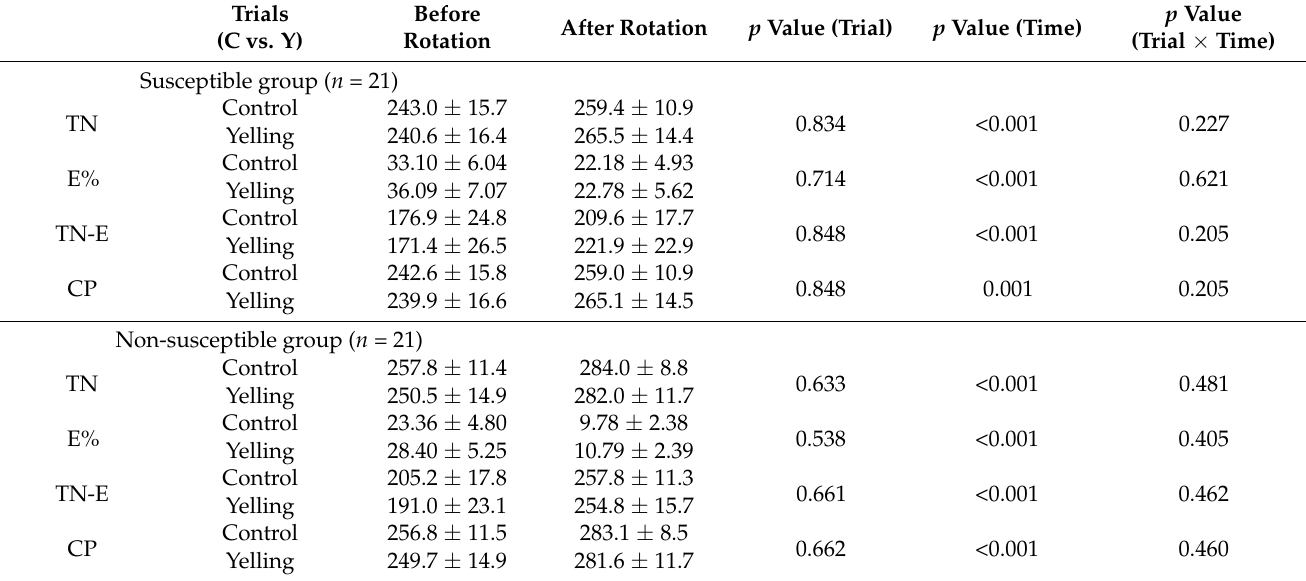
Table 1. Effect of the yelling intervention on attention between the susceptible and non-susceptible groups. Trials